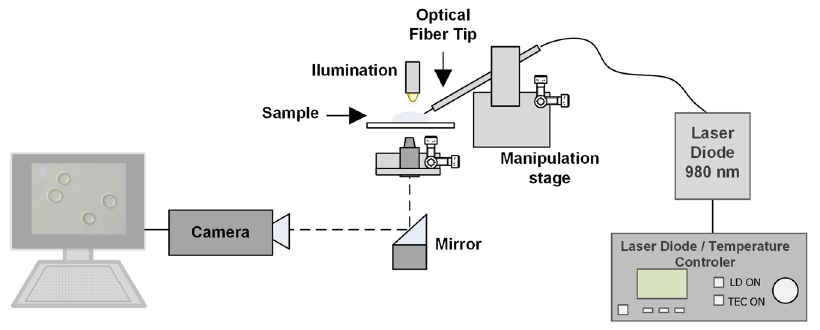
Figure 7. Optical manipulation